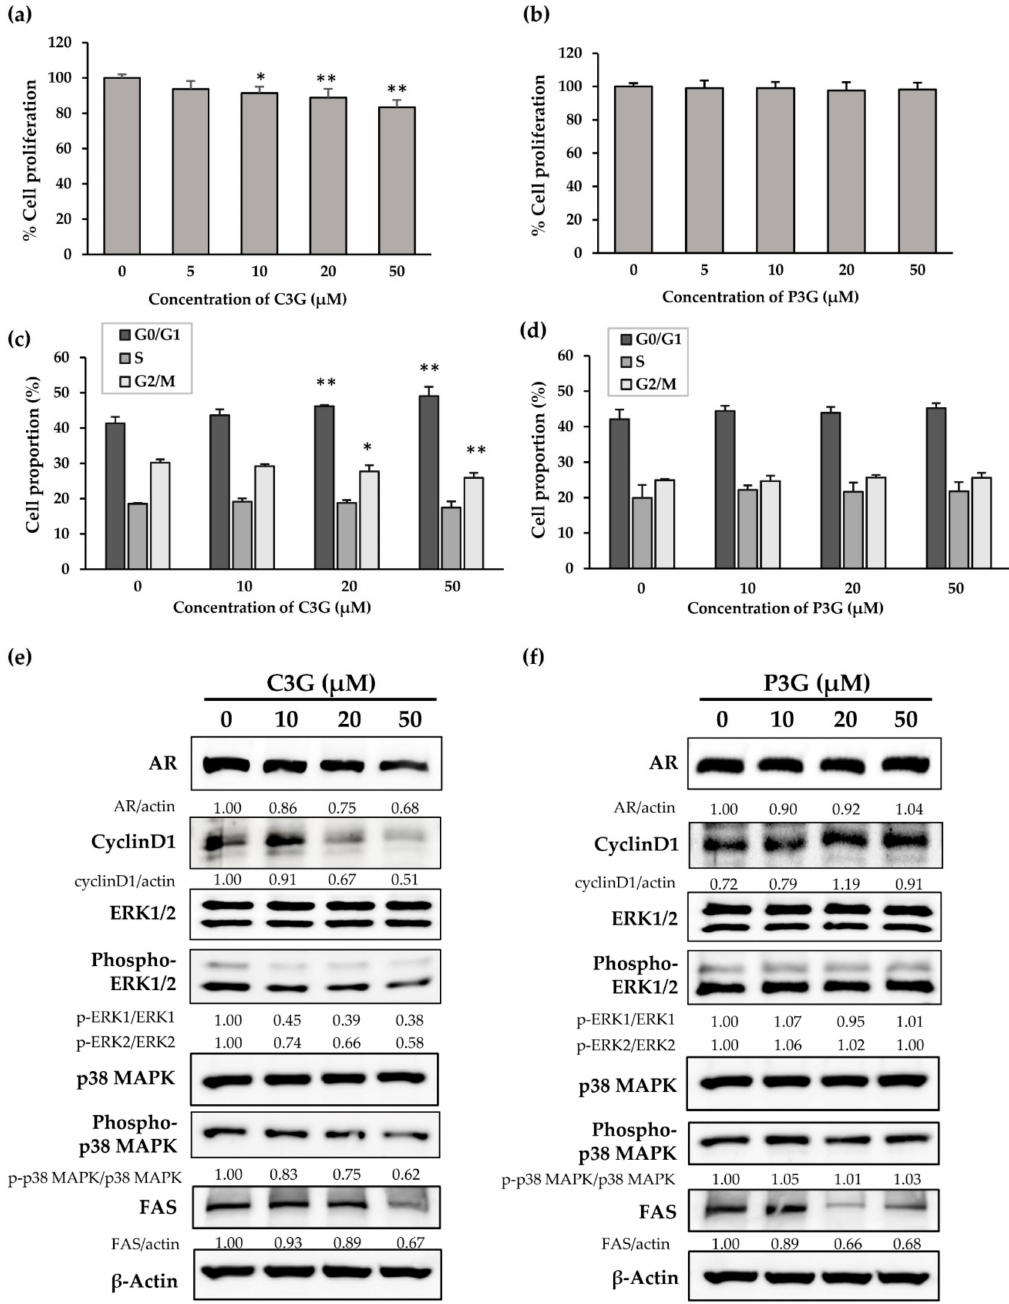
Figure 7. E ff ect of anthocyanins on PCai1 rat CRPC cell line. ( a ) Cell proliferation of PCai1 cells after incubation with C3G or ( b ) P3G. E ff ects of ( c ) C3G or ( d ) P3G on the cell cycle of PCai1 cells (72 h). ( e ) Immunoblots of protein lysates from PCai1 cells treated with C3G or ( f ) P3G for 72 h. All